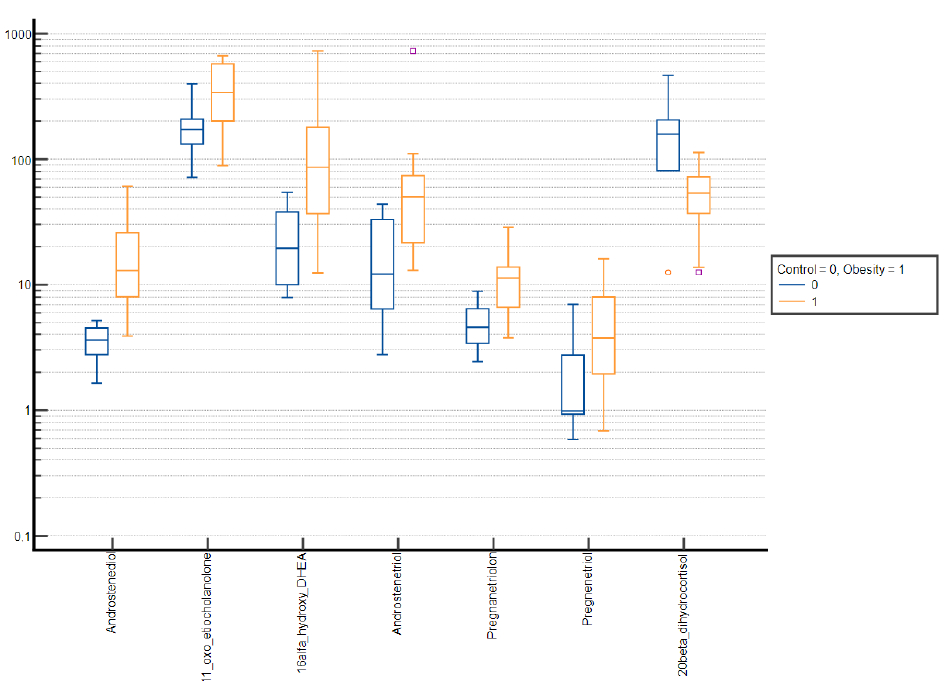
Figure 4. Comparative box plots of steroid metabolites with statistically significant differences ( p - value < 0.05) between the normal weight and obesity girls in the prepubertal group. A logarithmic scale was used. Exact results are available in Supplementary Table S3. Purple square – outliers, red circle – extreme values.